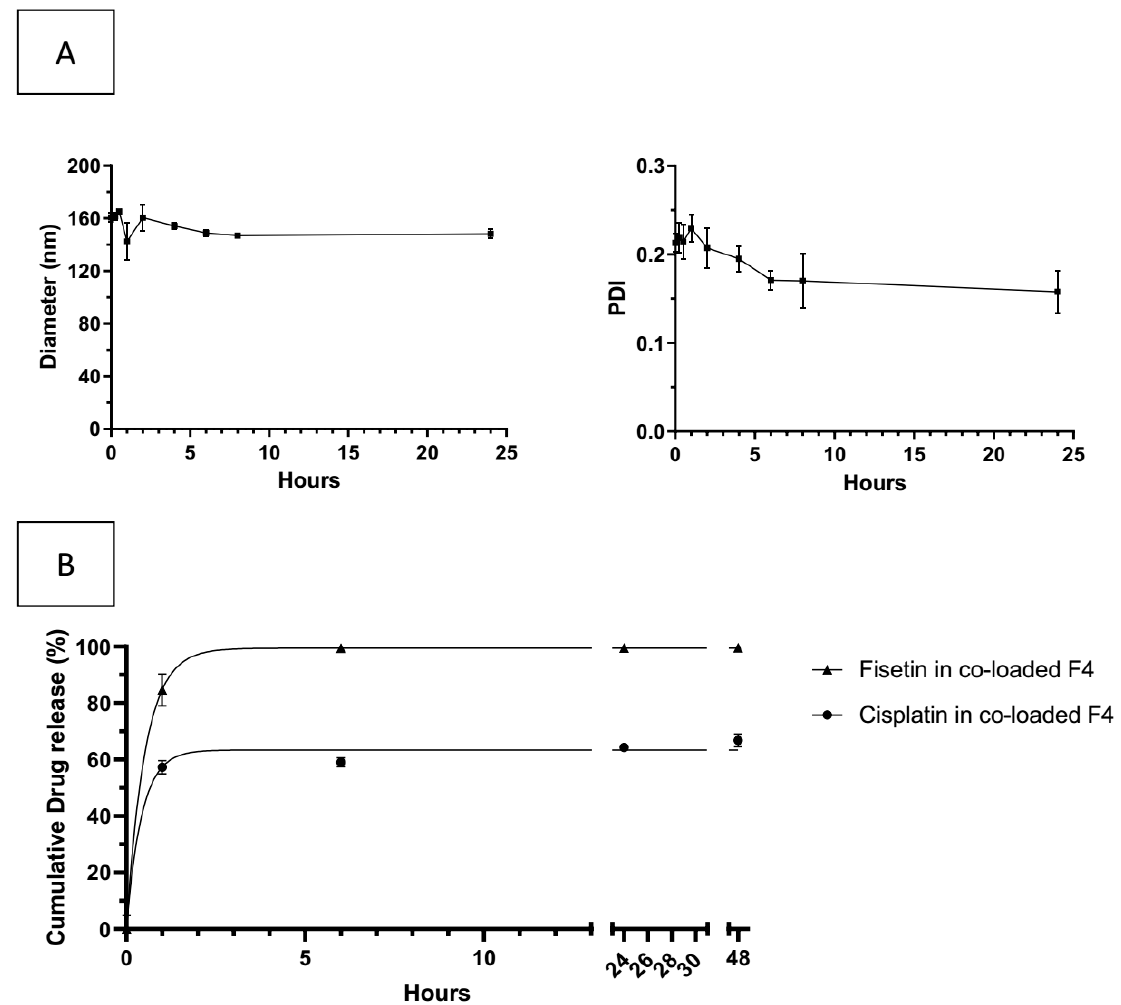
Figure 5. Stability of the formulation 4 co-encapsulating cisplatin and fisetin in complete culture medium (mean ± SD, n = 3). ( A ) stability of size and PDI. ( B ) In vitro release of cisplatin and fisetin by formulation 4 co-encapsulating cisplatin and fisetin in DMEM-C: liposomal cisplatin (circle) and liposomal fisetin (triangle).